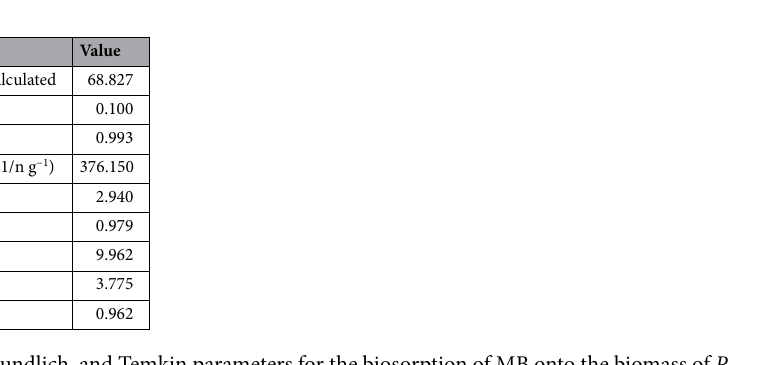
Table 6. Langmuir, Freundlich, and Temkin parameters for the biosorption of MB onto the biomass of P. alcaliphila NEWG-2